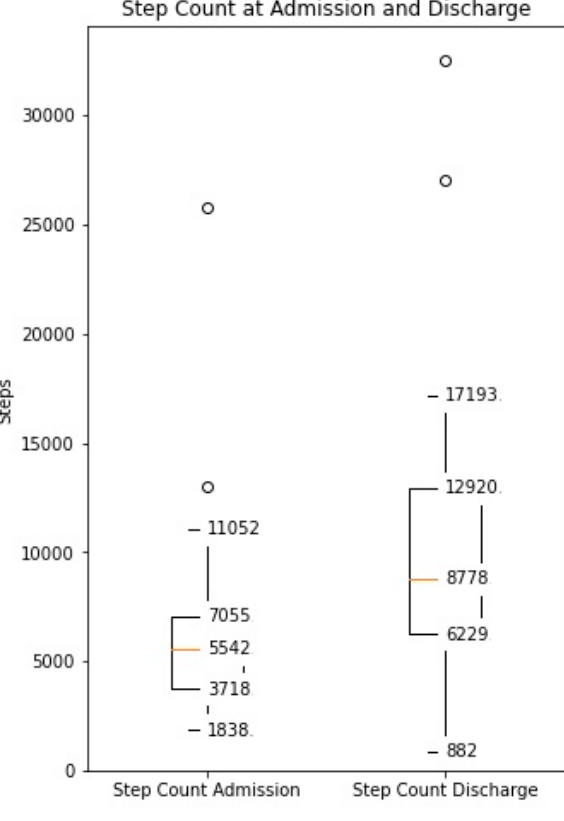
Figure 1. Median daily step count measured by the WCD at the time of admission and discharge Figure 1. Median daily activity level measured by the WCD at the time of admission and discharge Figure 1. Median daily activity level measured by the WCD at the time of admission and discharge to the CR clinic (Increased from a median 117 × 10 6 (IQR 96 × 10 6 –142 × 10 6 ) TVE to 146 × 10 6 (110 × to the CR clinic (Increase from median 5542 (IQR 3718–7055) to median 8778 (IQR 6229–12,920), to the CR clinic (Increased from a median 117 × 10 6 (IQR 96 × 10 6 –142 × 10 6 ) TVE to 146 × 10 6 (110 × 10 6 –169 × 10 6 ), p < 0.001). p < 0.001). 10 6 –169 × 10 6 ), p < 0.001).